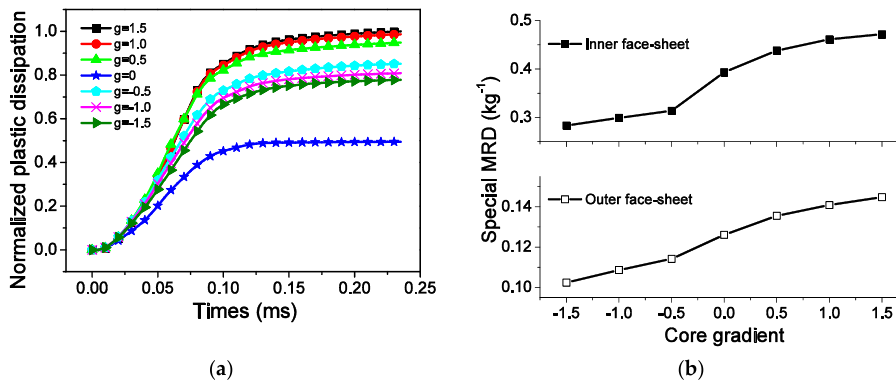
Figure 19. Influence of core gradient on EA and MRD. ( a ) EA, and ( b ) MRD.